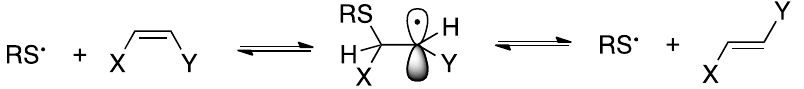
Table 1. Formation of trans isomers of monounsaturated fatty acid (MUFA) and consumption of polyunsaturated fatty acids (PUFA) residues 1 in liposome aqueous suspensions (2 mM) treated with